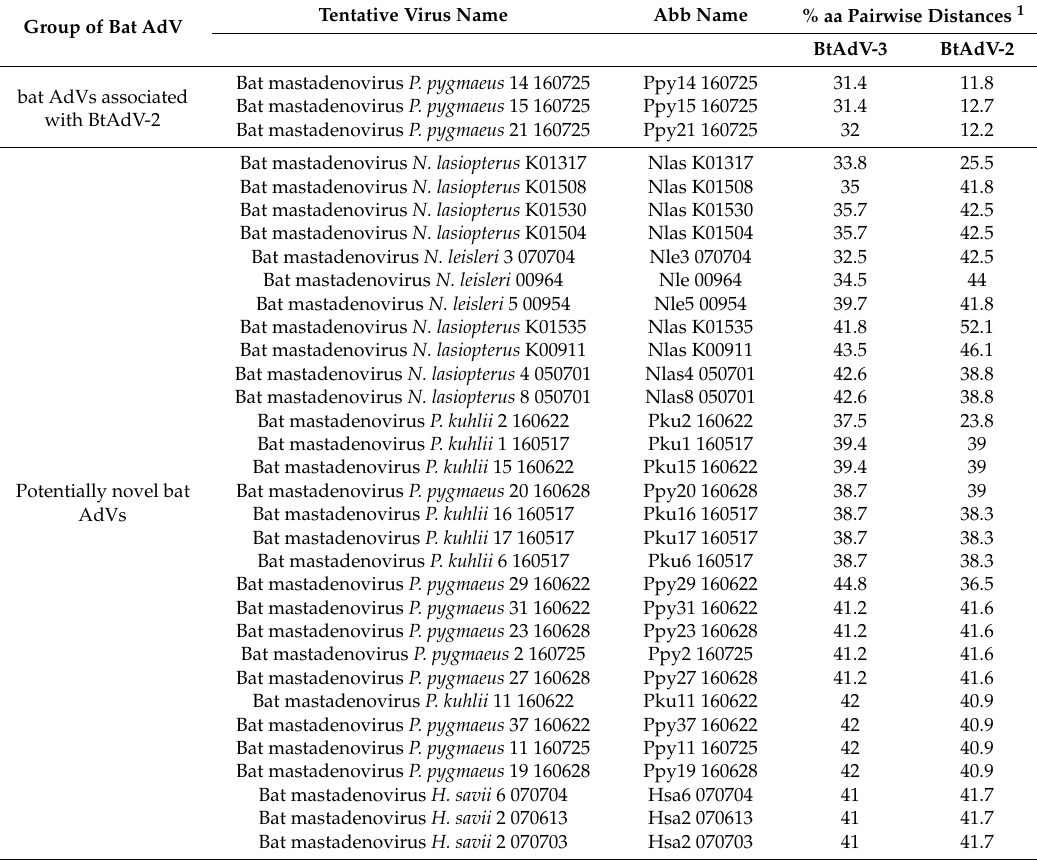
Table 2. Spanish bat mastadenoviruses classified by the amino acid distance matrix analysis based on partial DNA-dependent DNA polymerase. 1 Values more than 15% are potentially new species following the demarcation criteria. Abb: P: Pipistrellus . N: Nyctalus . H: Hypsugo